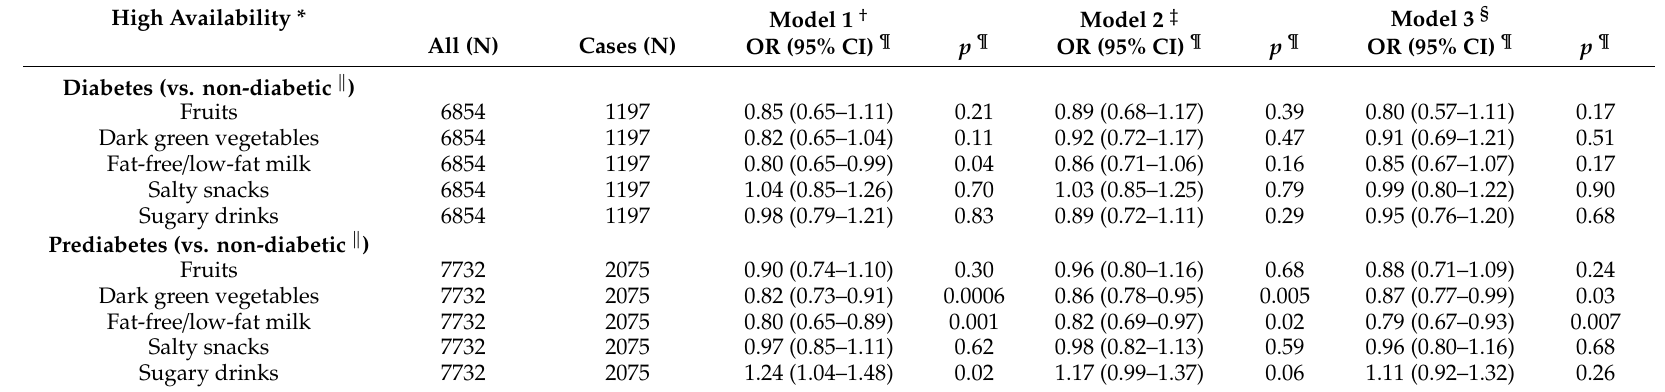
Table 2. Associations of the availabilities of individual food items with diabetes and prediabetes.